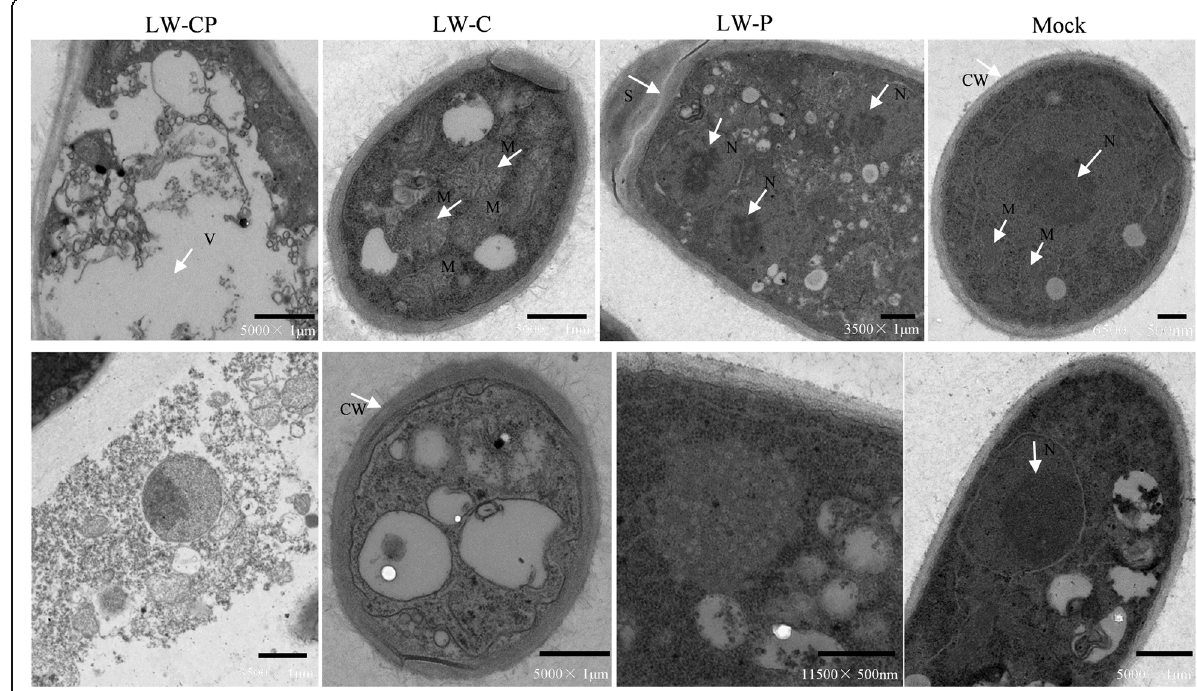
Fig. 2 Microscopic observation cell ultrastructure of fungal hyphae from Botryosphaeria dothidea strains (LW-CP, LW-C, LW-P and Mock) cultured on PDA for 48 h. V, vacuole; N, nucleus; CW, cell wall; M, mitochondria. The magnification and Scale bar was shown on the